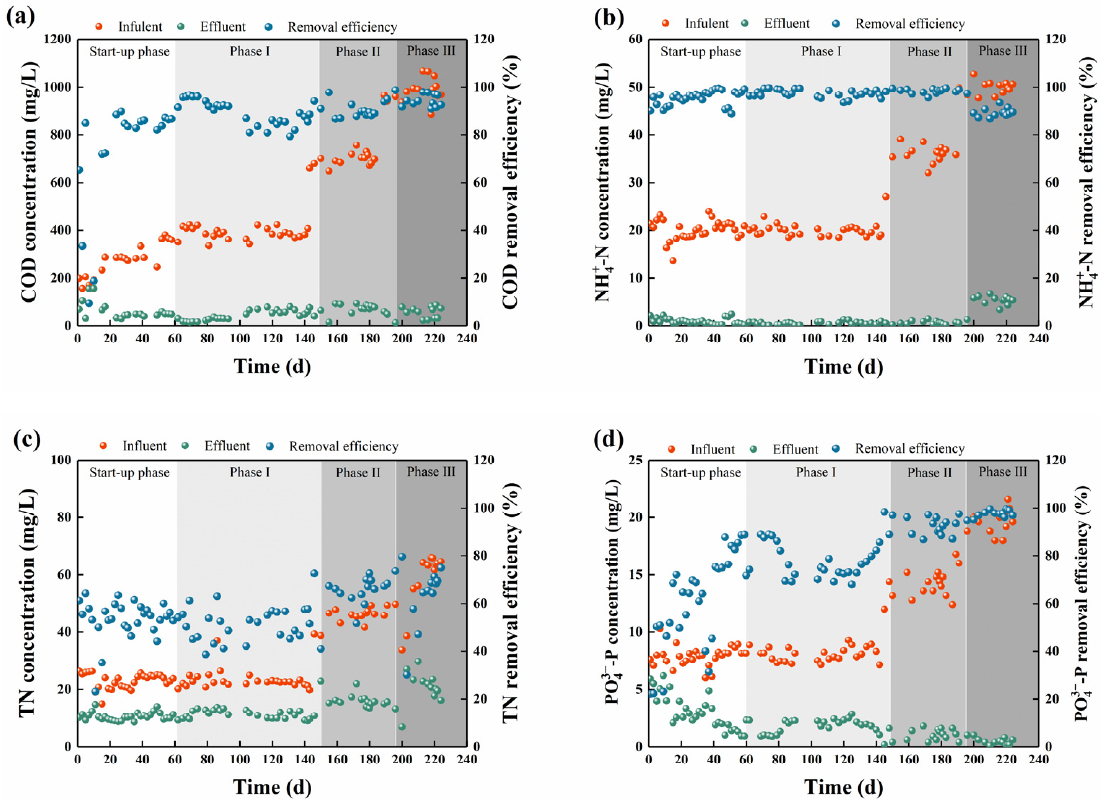
Figure 1. The removal performance of ( a ) COD, ( b ) NH 4+ -N, ( c ) TN, and ( d ) PO 43 − -P during the experiment.